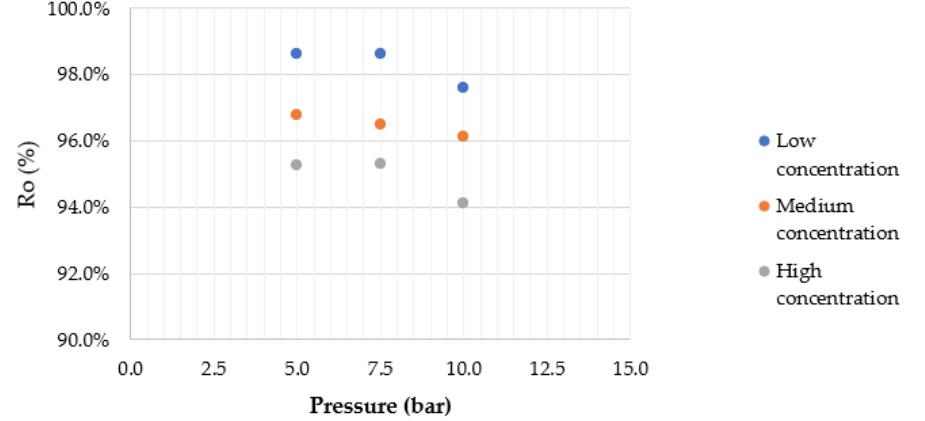
Figure 8. Influence of the applied pressure on As salt rejection (feed flow = 0.29 to 040 m 3 /h, feed concentration = 2.9, 15, and 29 mol/m 3 ).